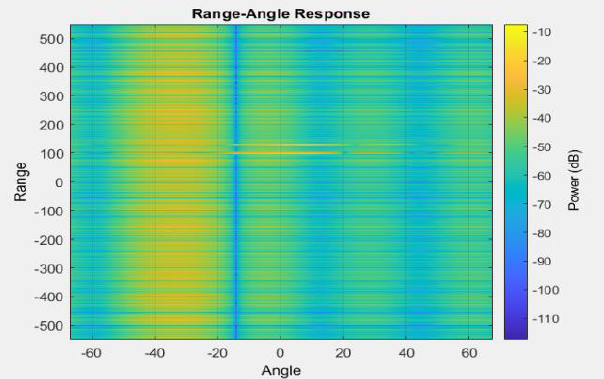
Fig. 11. Range-Angle response with clutter and jammer